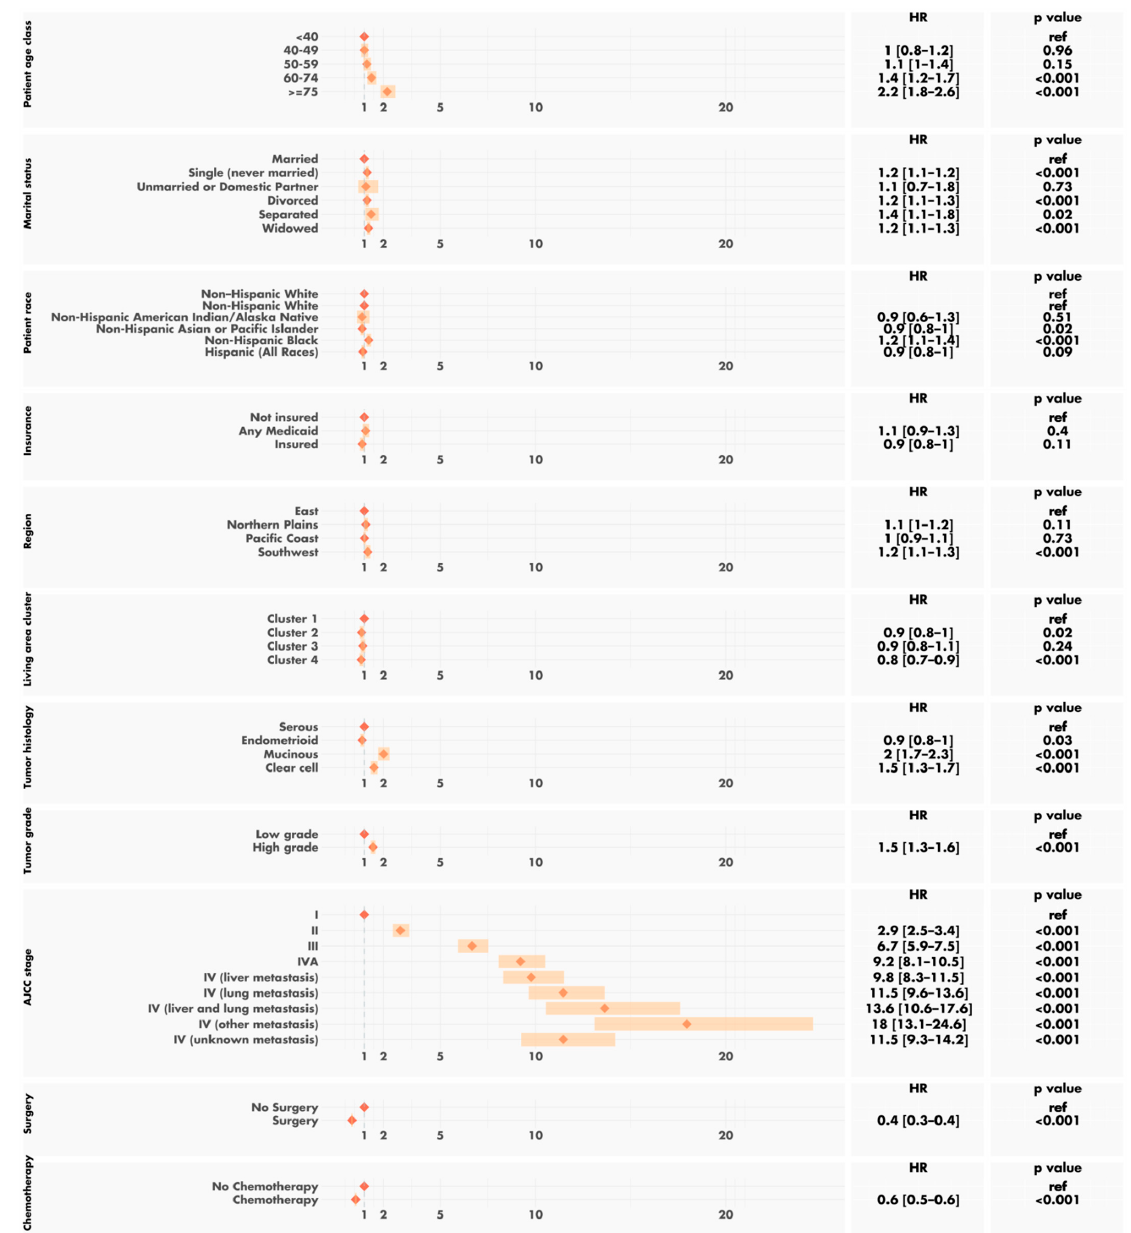
Figure 7. Multivariable survival analysis.